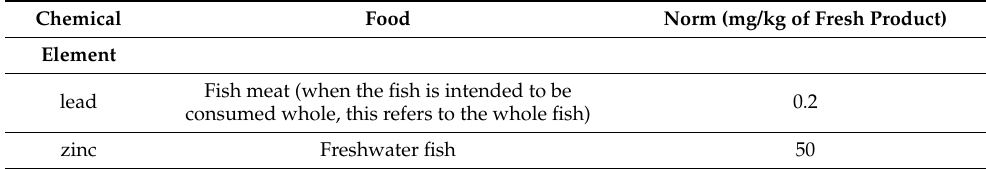
Table 2. Quality standards for the heavy metals lead and zinc in freshwater fish (under Regulation 31 of 29 July 2004 on the maximum permissible levels of contaminants in food).